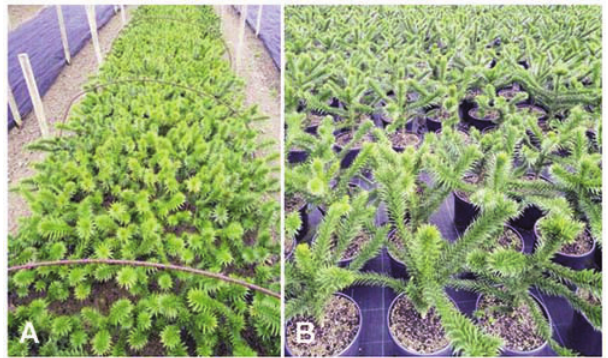
Fig. 7 - Araucaria araucana seedlings in Pistoia’s nurseries (A: two-year-old seedlings; B: six-year-old